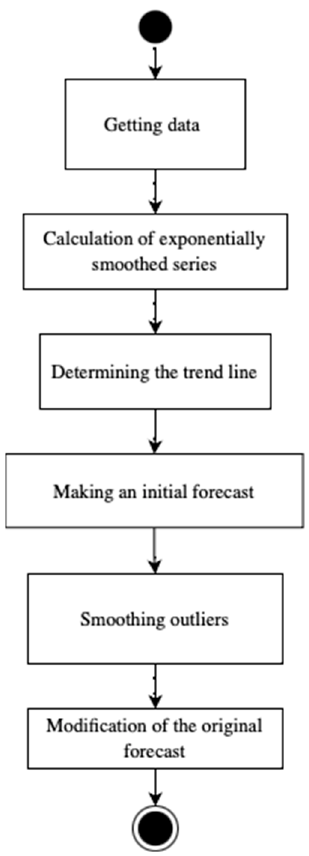
Figure 5. Algorithm of forecasting by the method of exponential smoothing Holt with an additional condition.